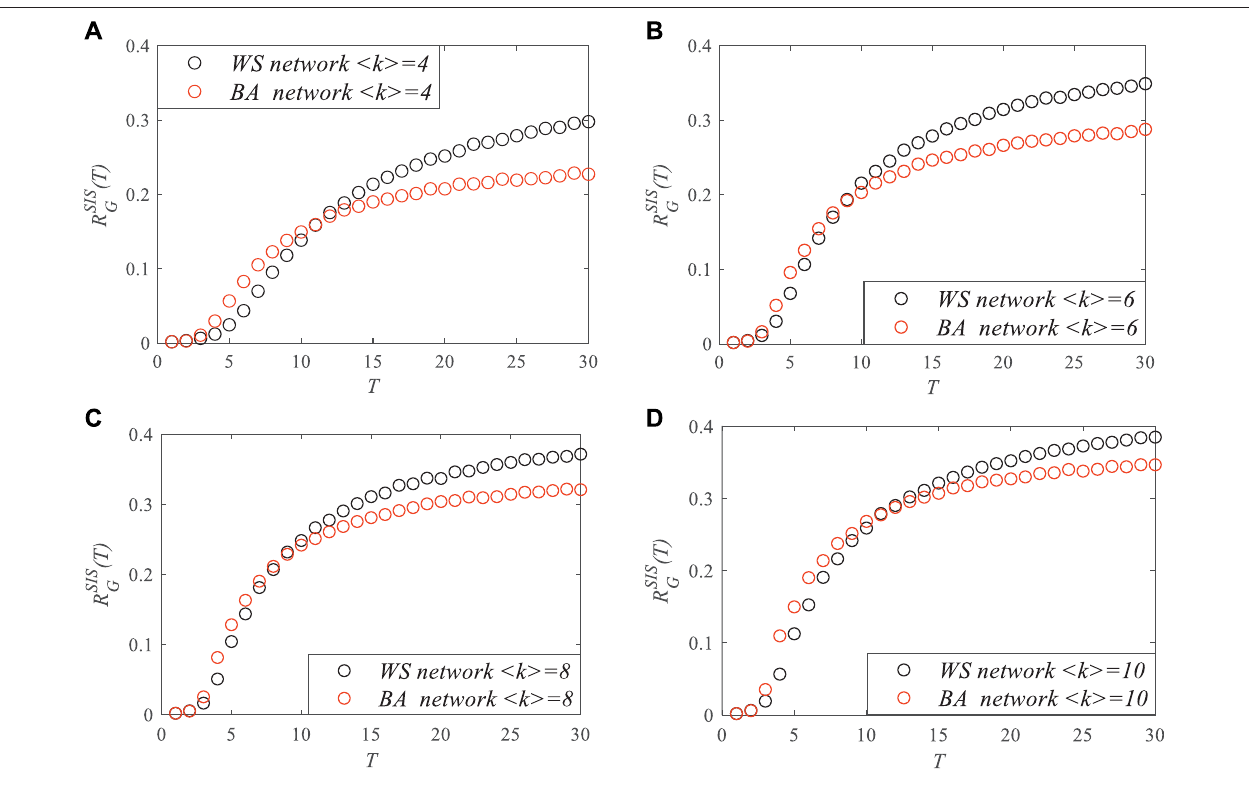
TABLE 2 | The real-world networks studied and their basic properties Networks N